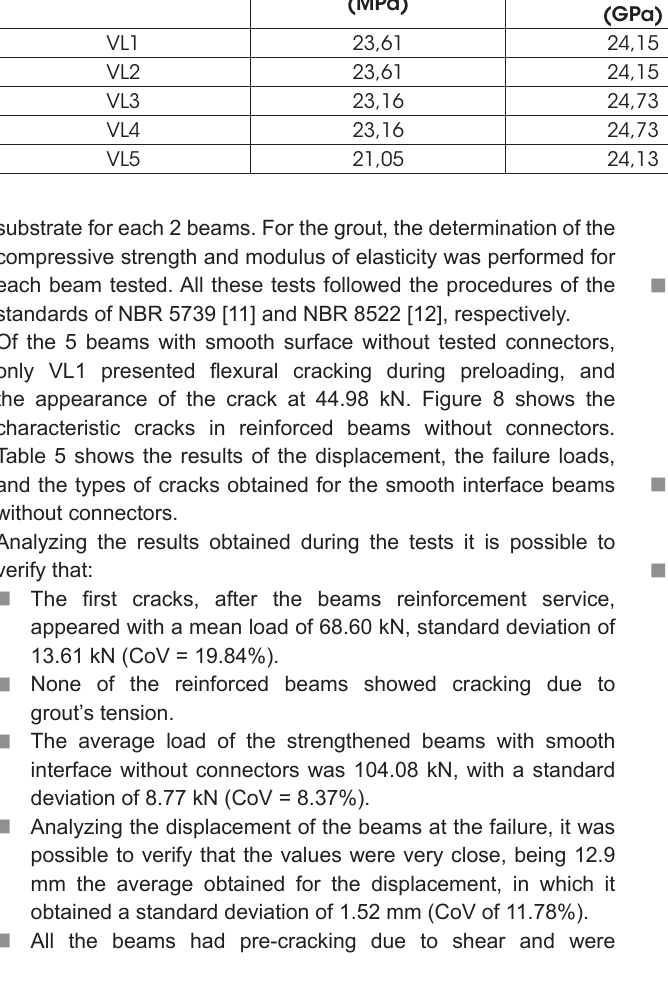
Table 4 Material information at the time of the test – beams with smooth interface without connectors Beam